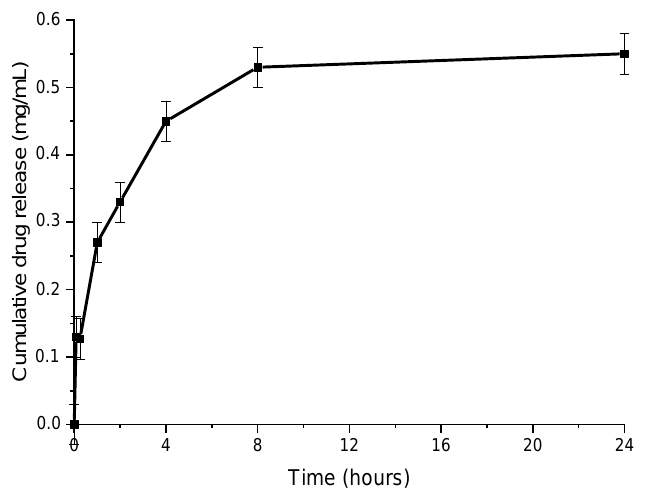
Figure 7. Release of isoniazid from albumin nanoparticles in phosphate-buffered saline.